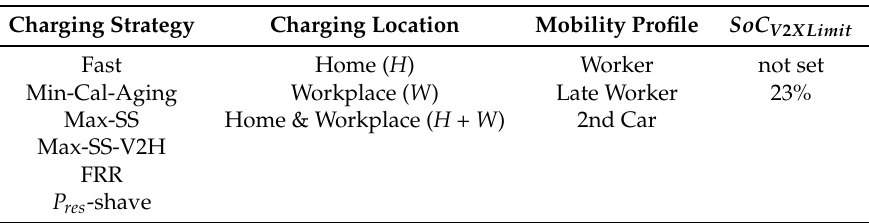
Table 3. Summary of scenario